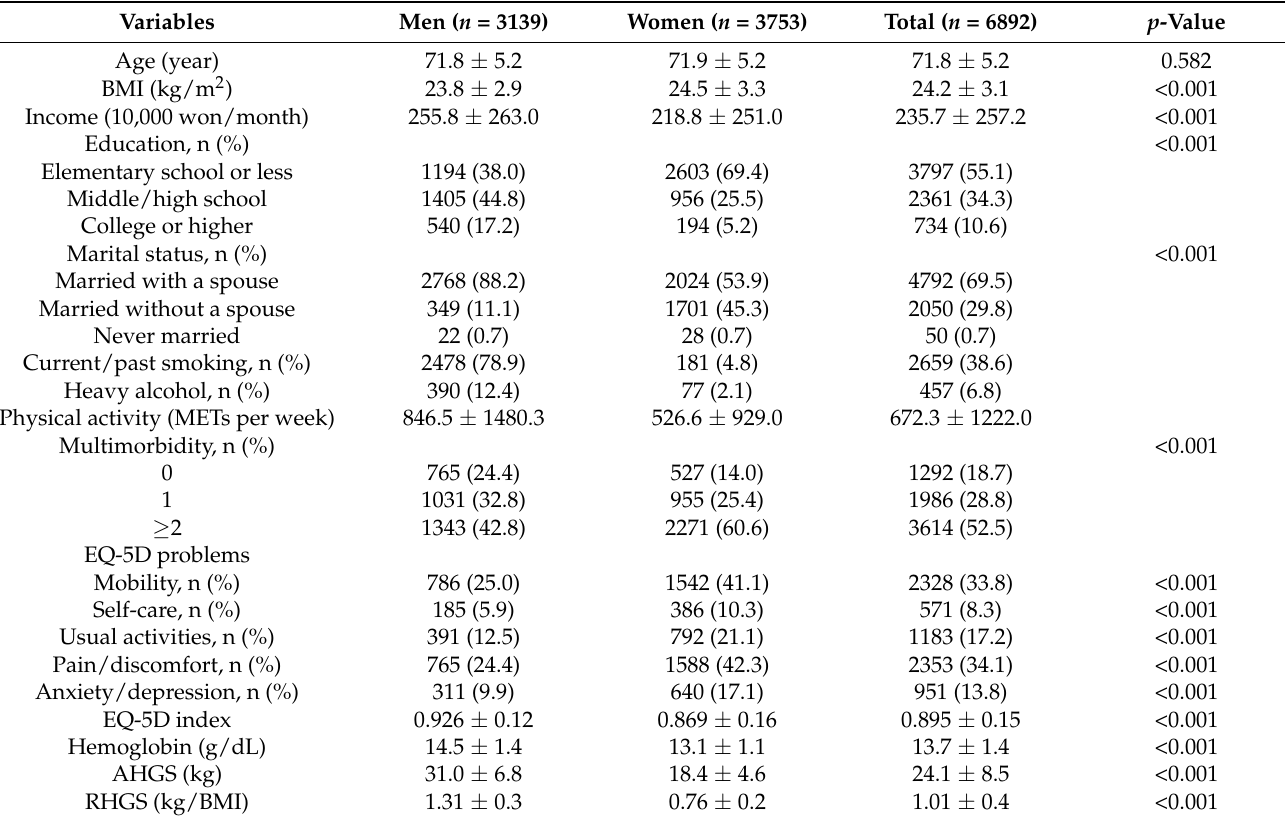
Table 1. Descriptive statistics of study participants by gender.